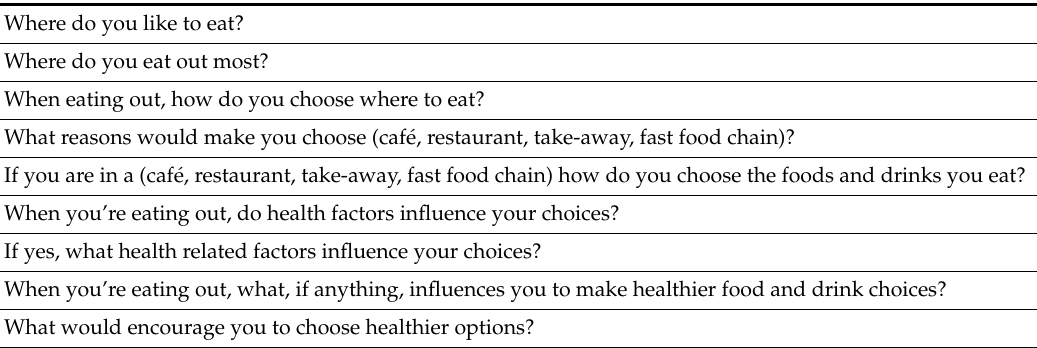
Table 1. Questions used to guide the focus group